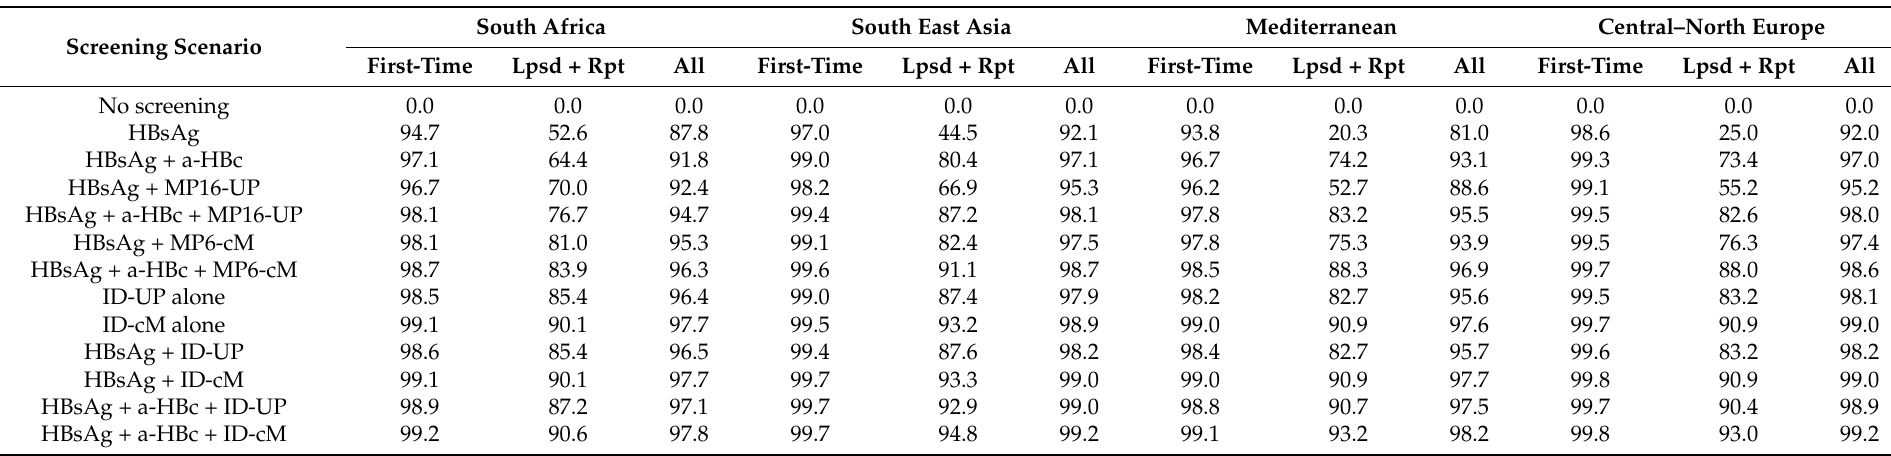
Table 4. Efficacy of screening scenarios in removing HBV transmission risk for different donation categories calculated by Weusten models [4,10] for RBC transfusions from residual risk percentages in four geographical regions (Table